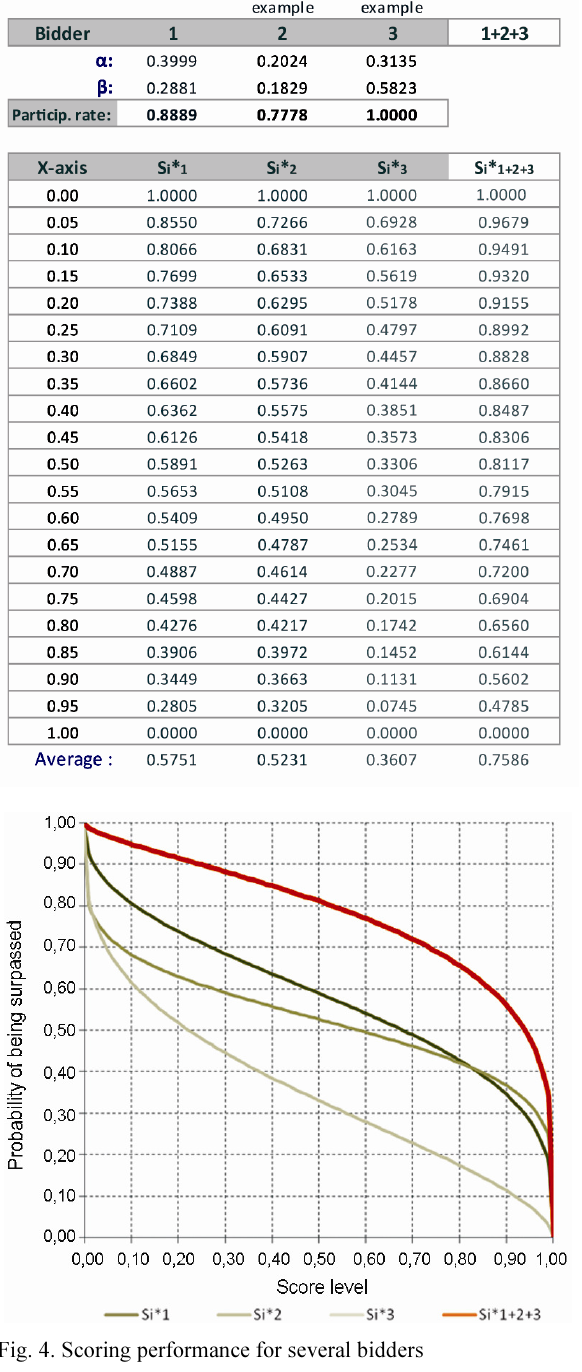
Table 4. Analysis of the Scoring (S i *) performances of a group of bidders